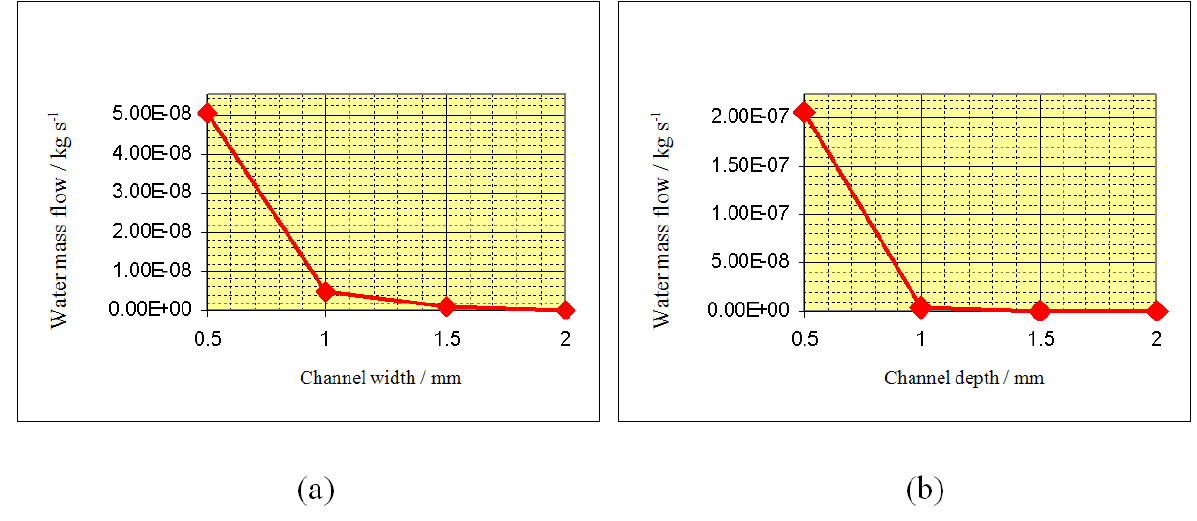
Figure 8. Water removal for cases varying channel width (a) and channel depth (b).